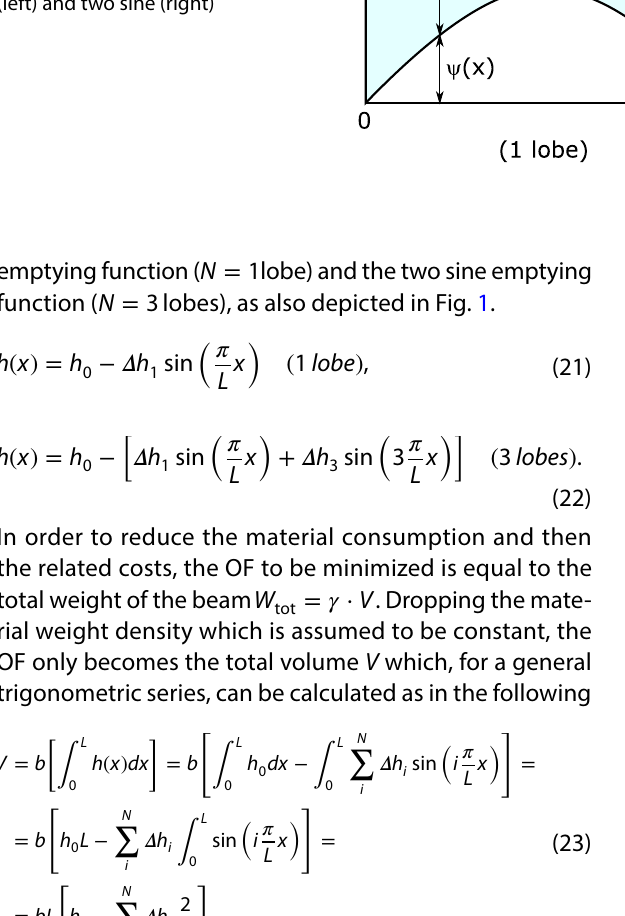
Fig. 1 Optimal emptied expected shape for a double fixed beam adopting an empty function with a one single sine (left) and two sine